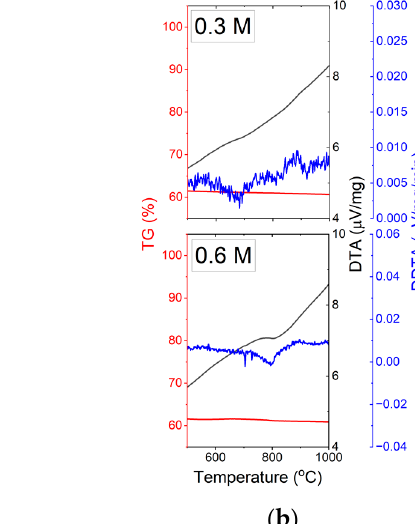
Figure 2. Typical DTA–TGA curves of dried TiO 2 precursor powders at a heating rate of ( a ) 10 C°/min and ( b ) 5 C°/min. Graphs of the first derivation of the DTA results are included.